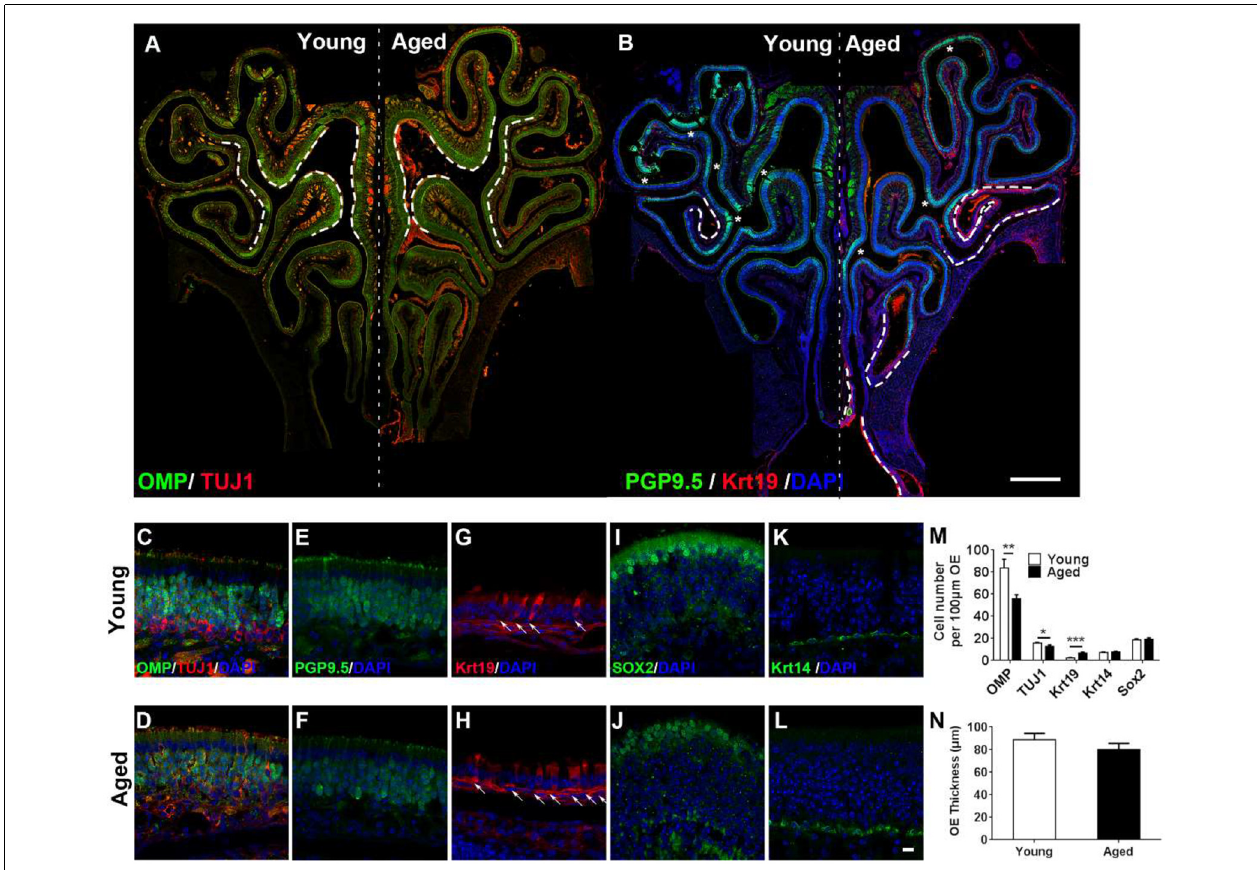
FIGURE 1 | Aging altered neuronal generation in the olfactory epithelium (OE). (A) Immunostaining against mature and immature sensory neuronal markers olfactory marker protein (OMP) and TUJ1 in the OE of young and aged mice at 3- and 25-month old. The positive signals against OMP were labeled by dash lines. (B) Immunostaining against sensory neuronal marker PGP9.5 (noted by asterisks) and columnar-ciliated respiratory epithelial cell marker Krt19 (noted by dash lines). (C–L) Confocal images of staining against OMP and TUJ1 (C,D) , PGP9.5 (E,F) , Krt19 ( G,H , for respiratory epithelial cells, labeled by arrows), Sox2 ( I,J , for apical supporting cells), and Krt14 ( K,L , for HBCs) in the OE of young and aged mice. Nuclei were counterstained with DAPI, as shown in blue. (M) Statistical analysis of OMP+, TUJ1+, Krt19+, Krt14+, and apical Sox2+ cell density in the OE of young and aged mice. In young and aged OE, 1,406 and 723 OMP+, 262 and 179 TUJ1+, 162 and 133 Krt19+, 98 and 139 Krt14+, and 182 and 222 apical Sox2+ cells were counted. (N) Statistical analysis of OE thickness from young and aged mice. Each OE thickness was calculated from 18 sections of three mice. The statistical significance was determined by unpaired t -test with